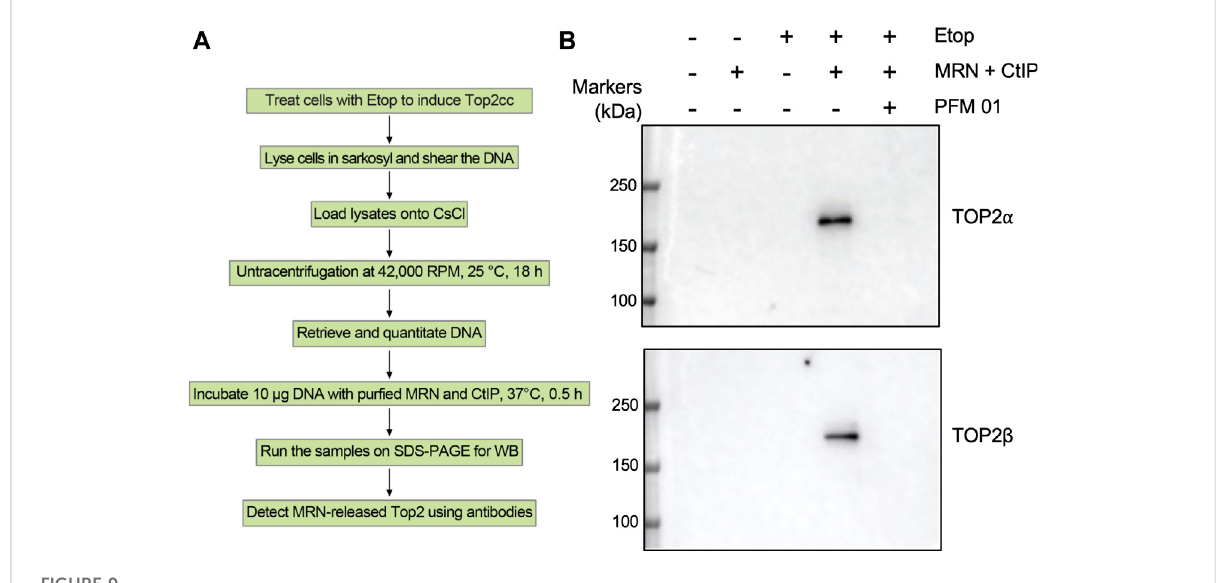
FIGURE 9 In vitro processing of TOP2 covalent complexes by puri fi ed MRN proteins. (A) Scheme for in vitro TOP2cc repair assay using ICE samples. (B) HEK293cellsweretreatedwithEtoposide(10 μ M)for30 minandthensubjectedtoICEassaystoinduceTOP2cc.10 µgDNAsamplesisolatedbyICE assay wereincubatedwith puri fi edhuman MRN complex (100 nM) and CtIP (100 nM) for 30 min at 37 ° C, followedby addition of Laemmli buffer and Western